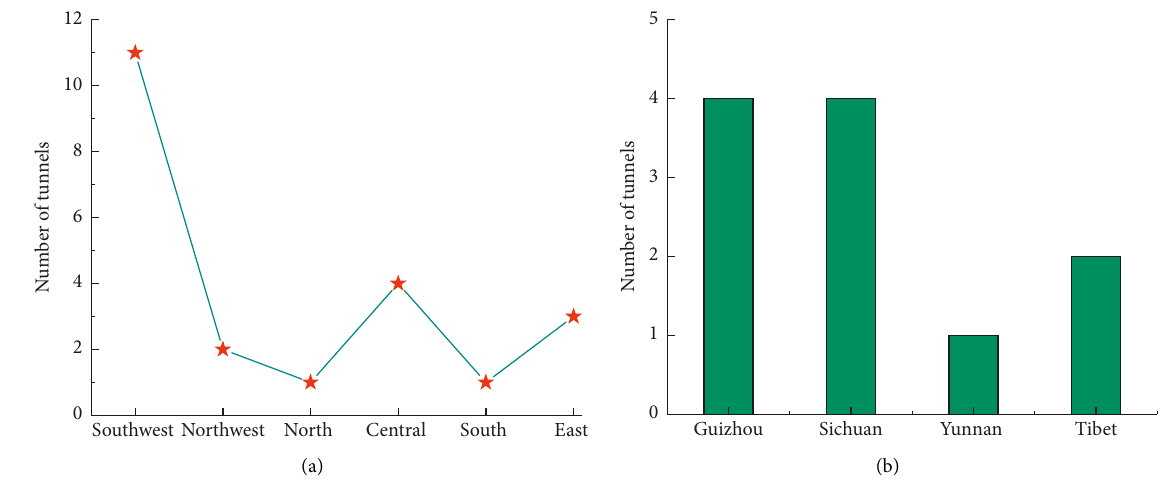
Figure 18: Application distribution of ECHBT in (a) China and (b) Southwest China [45–75]. Table 2: Comparison of cost per linear meter between ECHBT and conventional blasting technology [47]. Drilling and blasting cost Blasting method